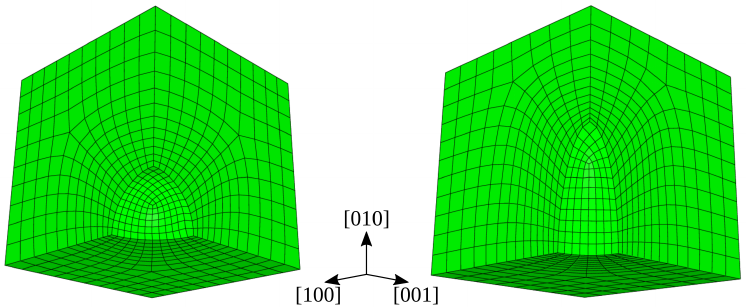
Figure 7. 1/8th spherical ( left ) and 1/8th ellipsoidal ( right ) model mesh configurations used in HIP